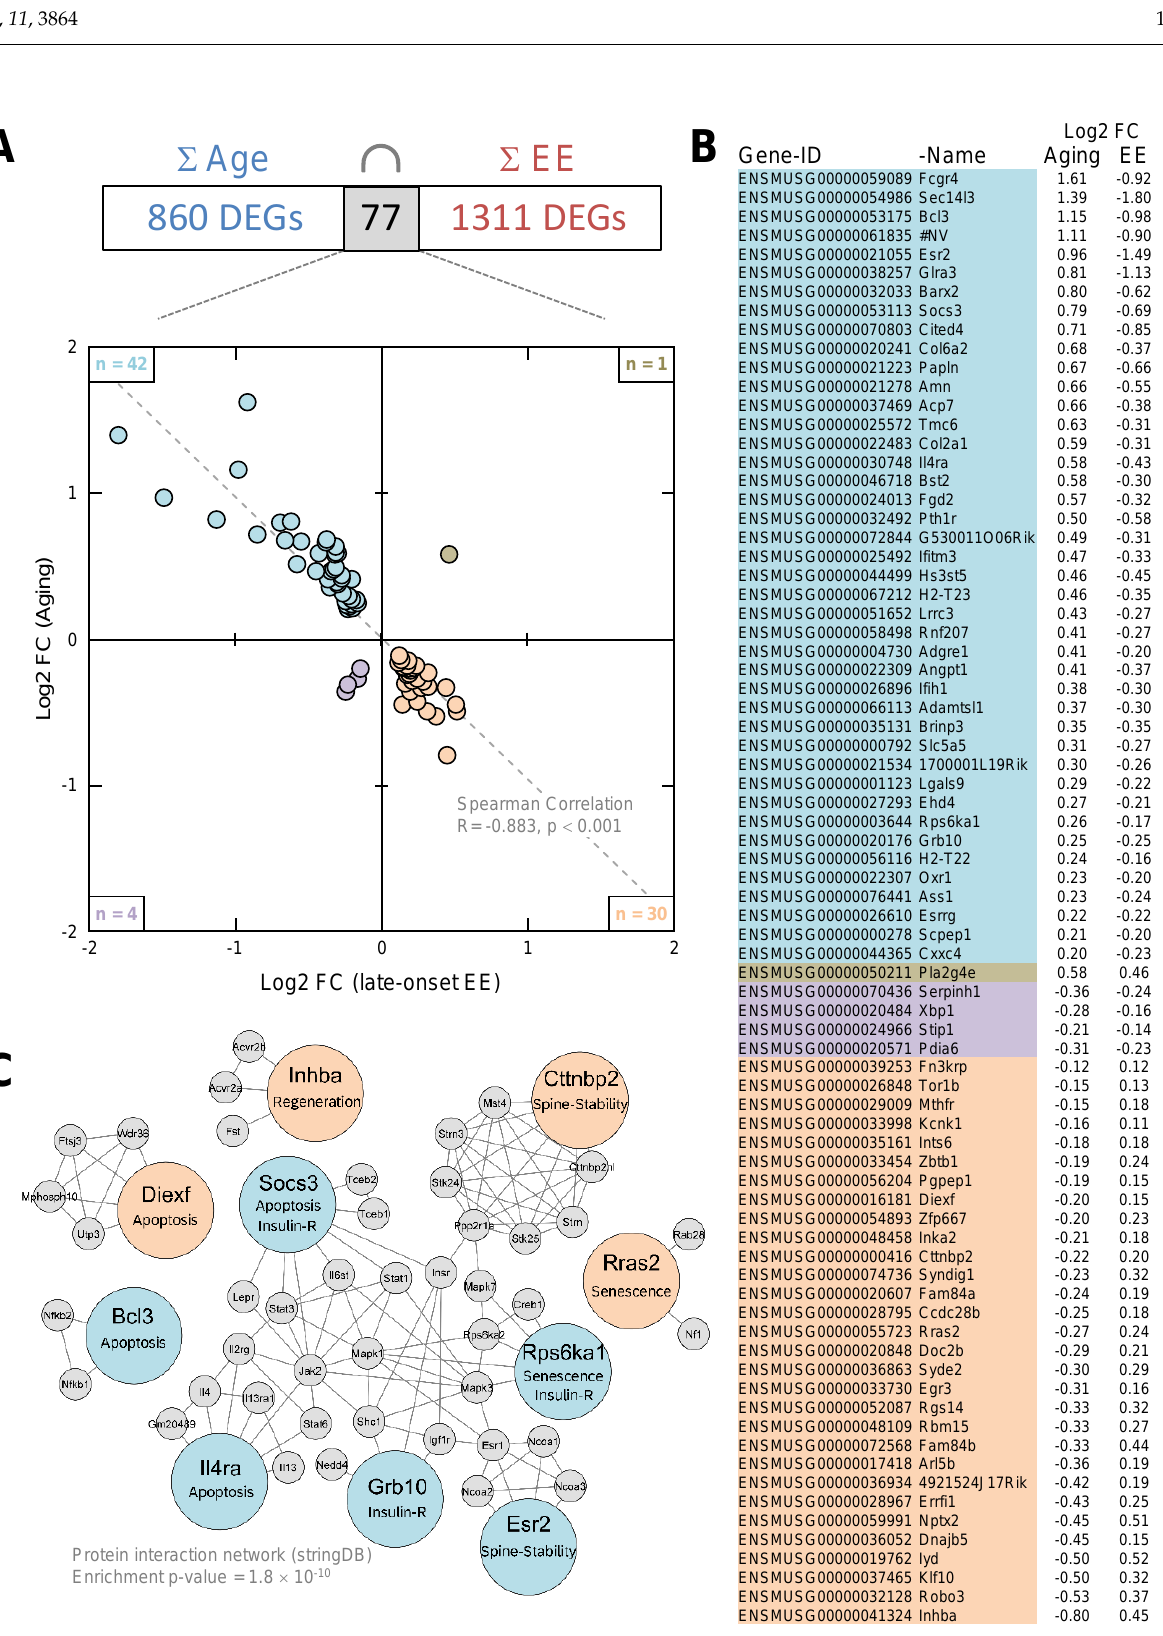
Figure 3. Late-onset EE partially reverses age-related hippocampal gene expression changes. ( A ) A small intersection of n = 77 age-related DEGs was affected by late-onset EE. The scatter plot